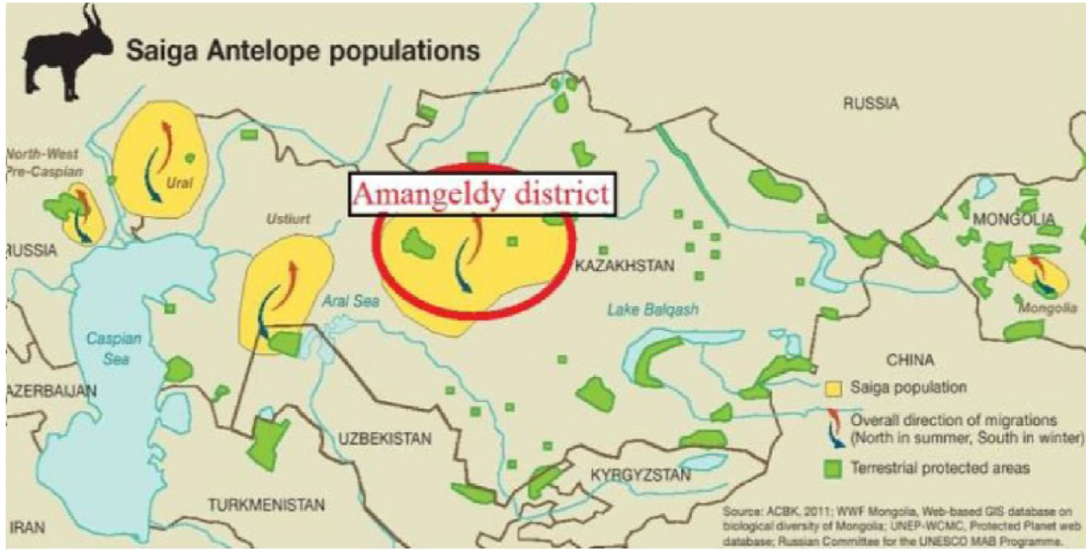
Fig. 1. Saiga population, Amangeldy District